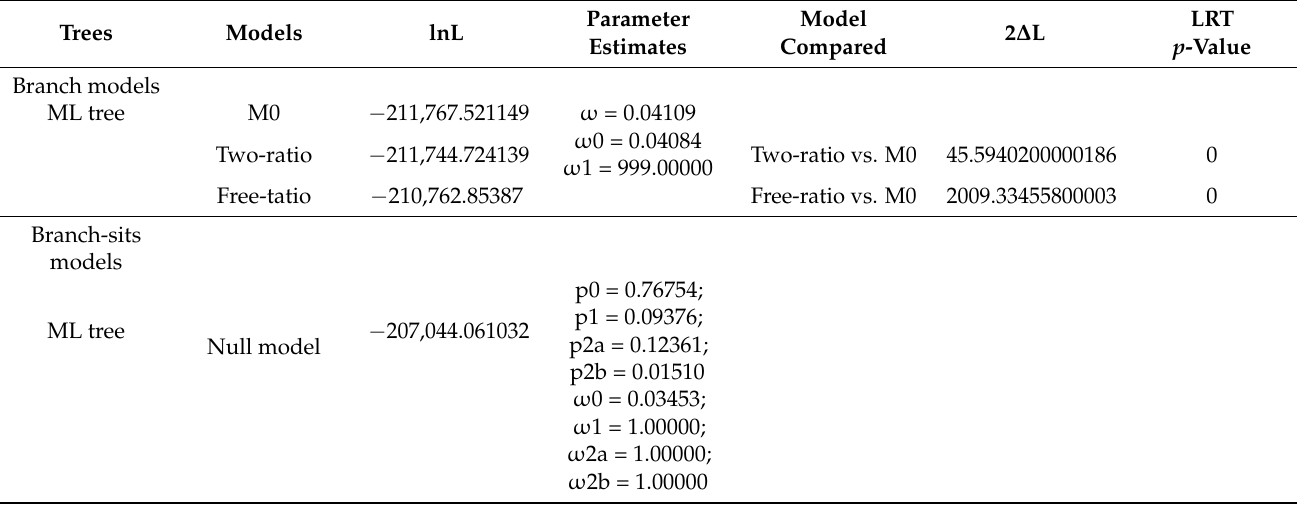
Table 3. CodeML analyses of selection pressure on mitochondrial genes in Eucrate crenata